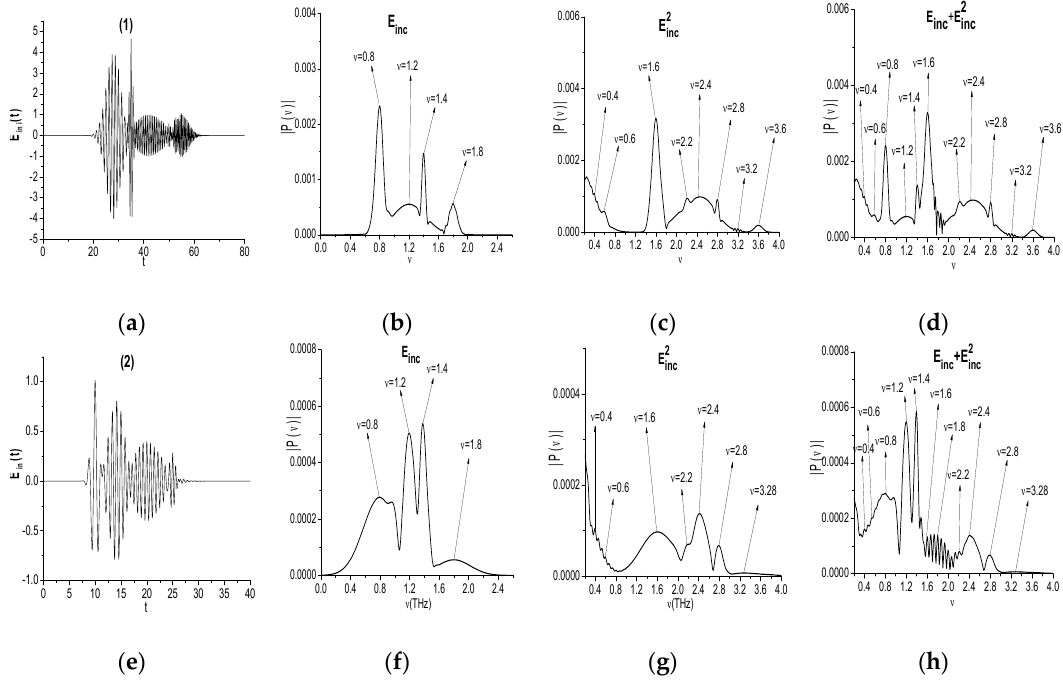
E t spectra (c,g) and in с